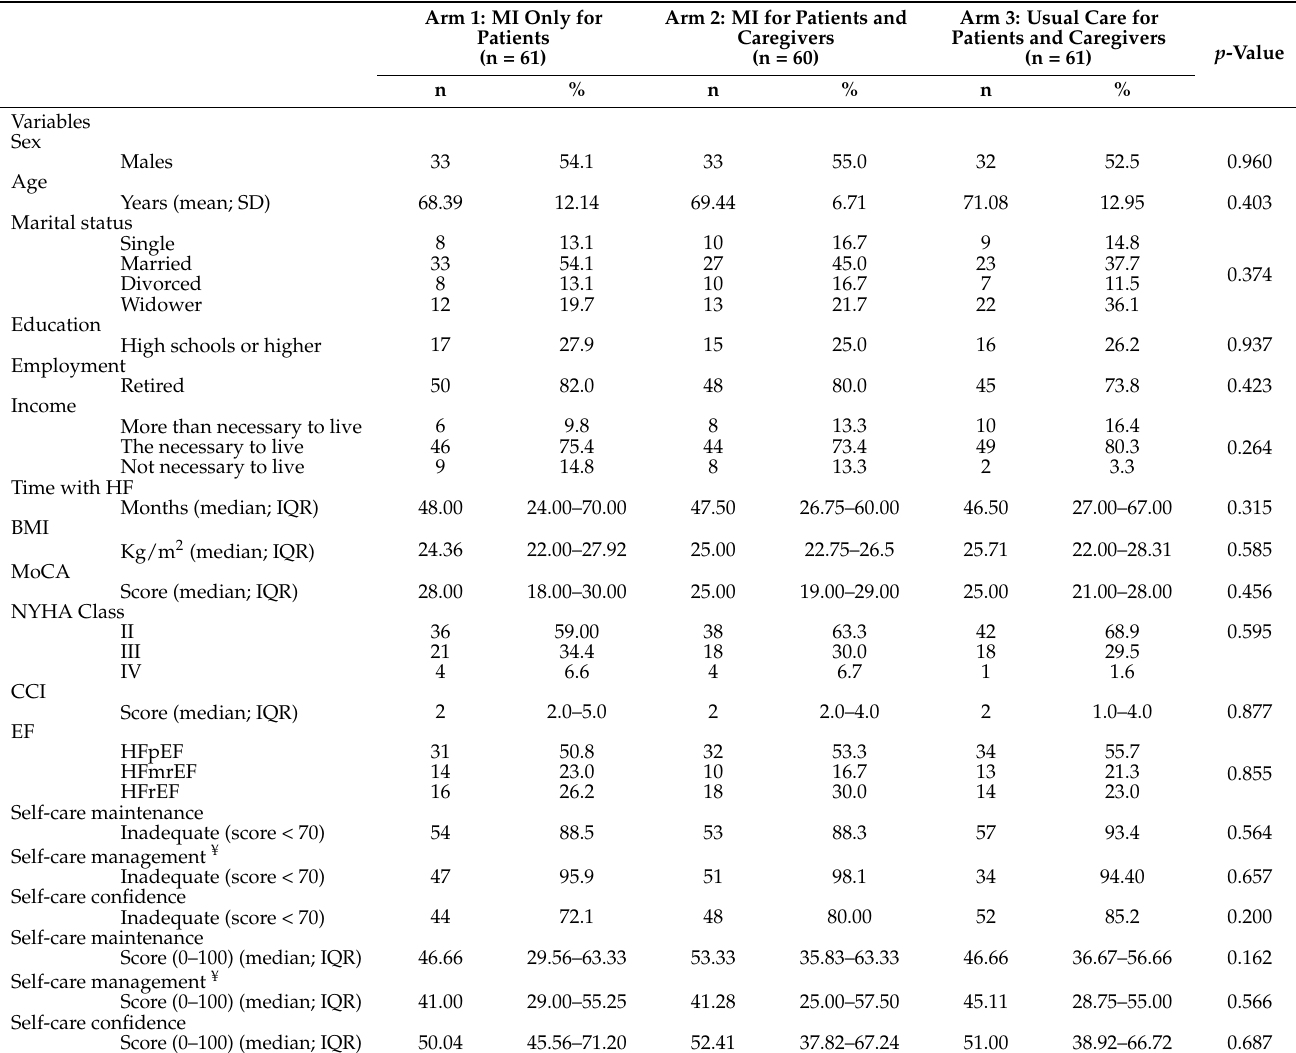
Table 1. Patients’ characteristics at baseline (n =